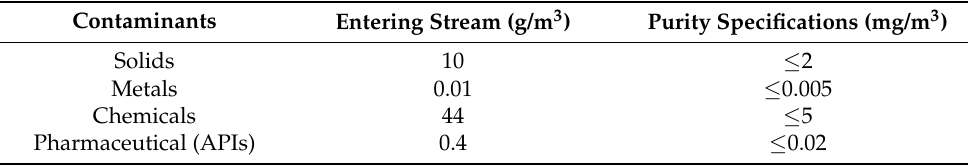
Table 6. WW characterization: inlet concentrations and outlet